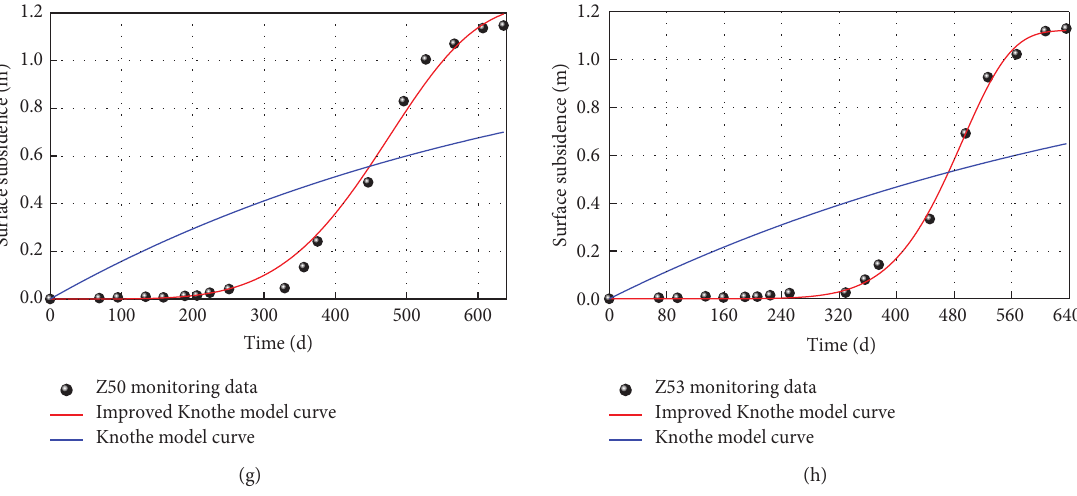
Figure 6: Comparison of two time function models. (a) Z29; (b) Z37; (c) Z41; (d) Z44; (e) Z45; (f) Z47; (g) Z50; and (h) Z53. Table 2: Time influence parameters of different monitoring points.